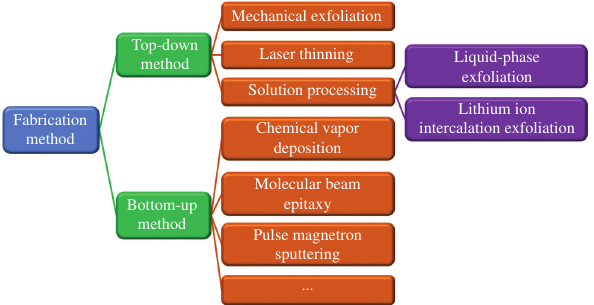
Figure 1: Typical fabrication methods of 2D materials including transition-metal dichalcogenides (TMDCs) and black phosphorus